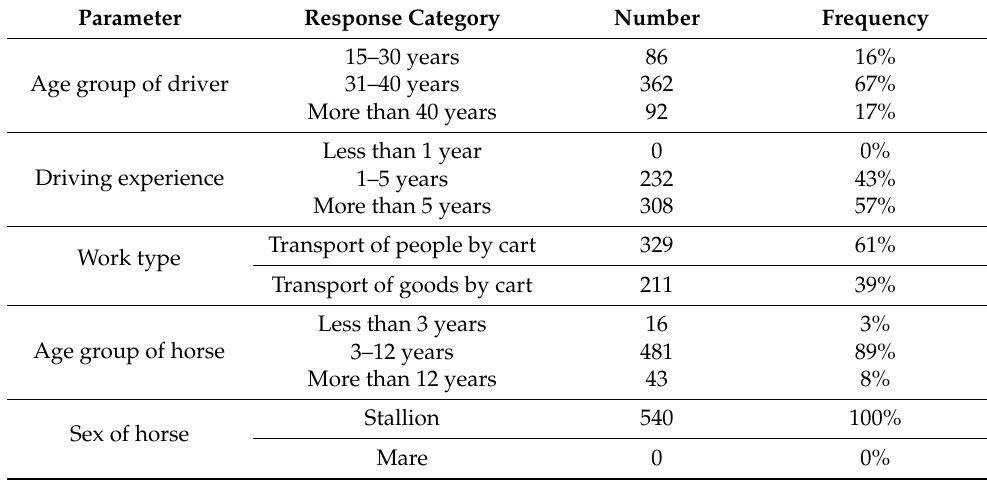
Table 5. Demographic information on drivers and horses during the experimental phase ( n =